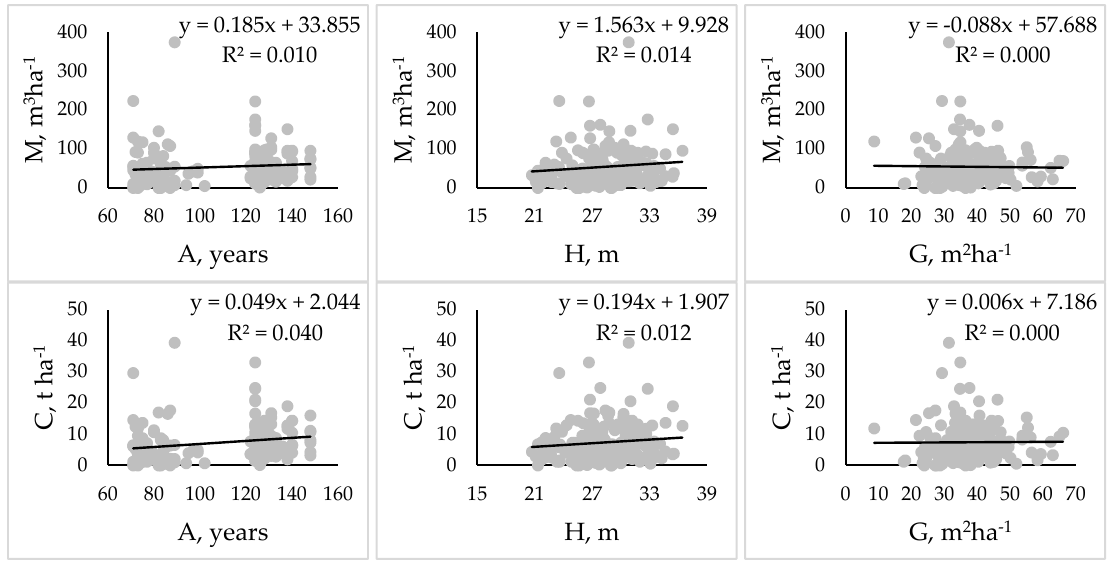
Figure 2. Volume of deadwood (M) and deadwood carbon pool size (C) in relation to stand age (A), stand height (H), and stand basal area (G) in unmanaged stands.